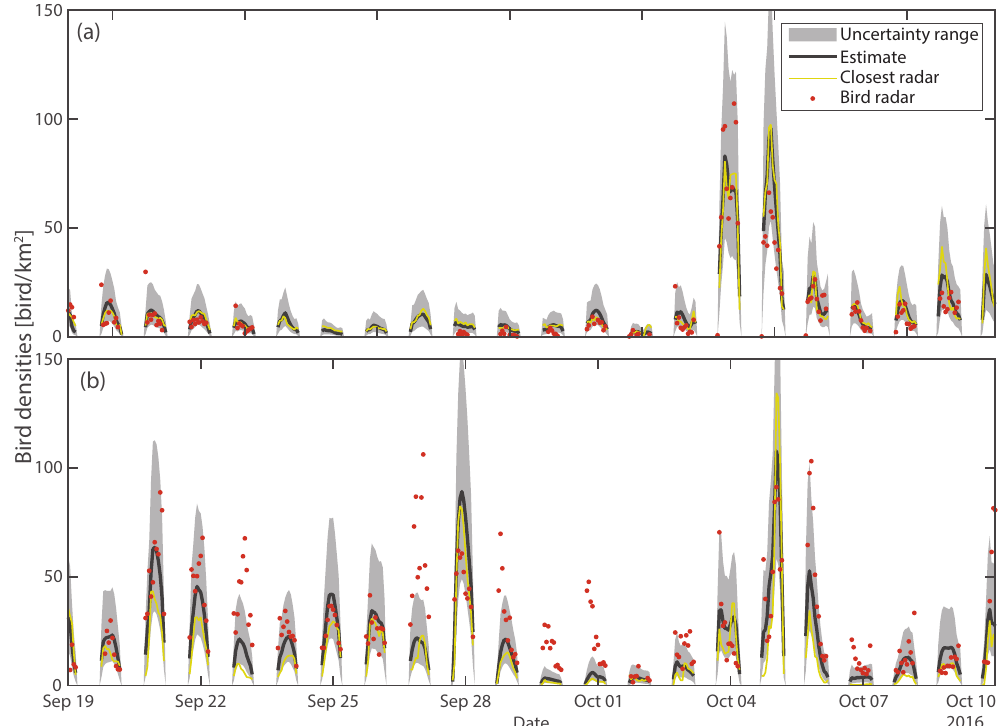
Figure 4. Comparison of the estimated bird densities (black line) and their uncertainty range (10–90 quantiles in gray) with the bird densities (red dots) observed using dedicated bird radars at two locations in ( a ) Herzeele, France (50 ◦ 53 (cid:48) 05.6 (cid:48)(cid:48) N 2 ◦ 32 (cid:48) 40.9 (cid:48)(cid:48) E), and ( b ) Sempach, Switzerland (47 ◦ 07 (cid:48) 41.0 (cid:48)(cid:48) N 8 ◦ 11 (cid:48) 32.5 (cid:48)(cid:48) E). Note that, because of the power transformation, model uncertainties are larger when the migration intensity is high. It is therefore critical to account for the uncertainty ranges (light gray) when comparing the interpolation results with the bird radars observations (red